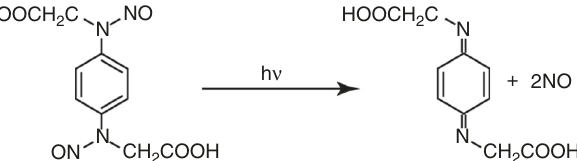
Fig. 2 Caged-NO photolysis. One caged-NO releases two NO molecules upon UV light